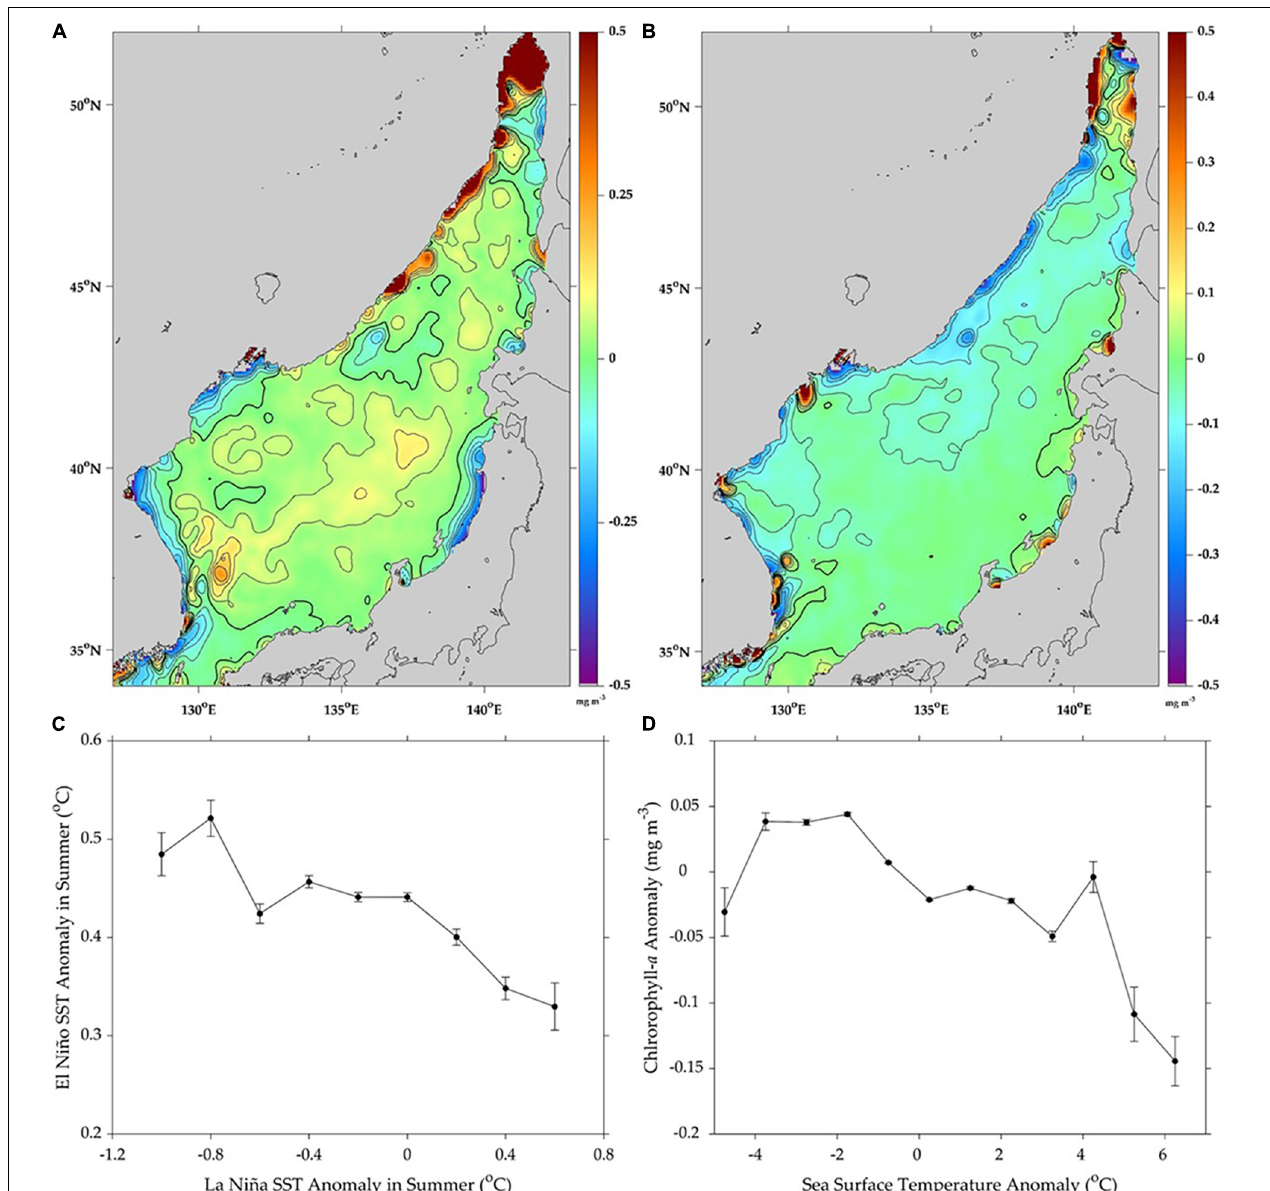
FIGURE 14 | Spatial distributions of MODIS chlorophyll- a concentration anomalies averaged for the periods of (A) El Niño (ENSO index > 1) and (B) La Niña (ENSO index < -1) in the East Sea (Japan Sea) in summer (June–August) from 2003 to 2020. (C) Sea surface temperature anomalies (SSTA) during El Niño (ENSO index > 1) against SSTA during La Niña (ENSO index < 1) in the entire region of the East Sea (Japan Sea) in summer (June–August) from 2003 to 2020 and (D) chlorophyll- a concentration anomaly as a function of the SST anomaly for high amplitude (|MEI| > 1) ENSO periods for the same period of (C) . Error bars represent √ the mean error ( σ / N − 1, σ : standard deviation, N : the data number) within a given